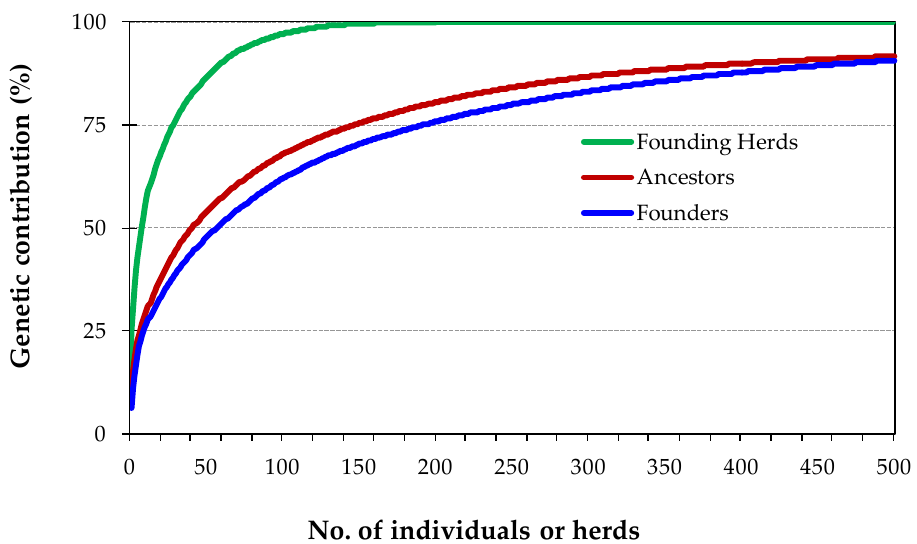
Figure 10. Cumulative genetic contribution to the reference population of the most influential founders, ancestors and herds.